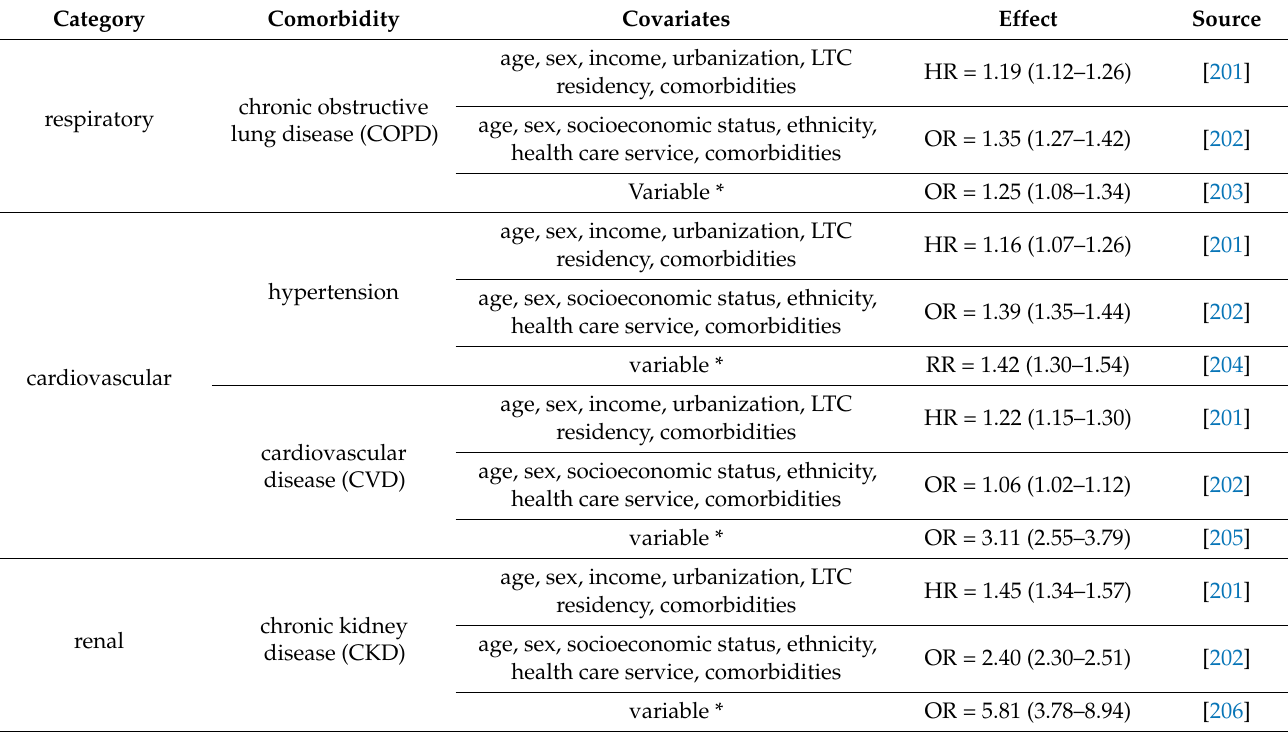
Table 3. Prevalent comorbidities with highly supported association with the risk of in-hospital COVID-19 mortality. The sources shown are either meta-analyses that found a significant summary effect, or large clinical